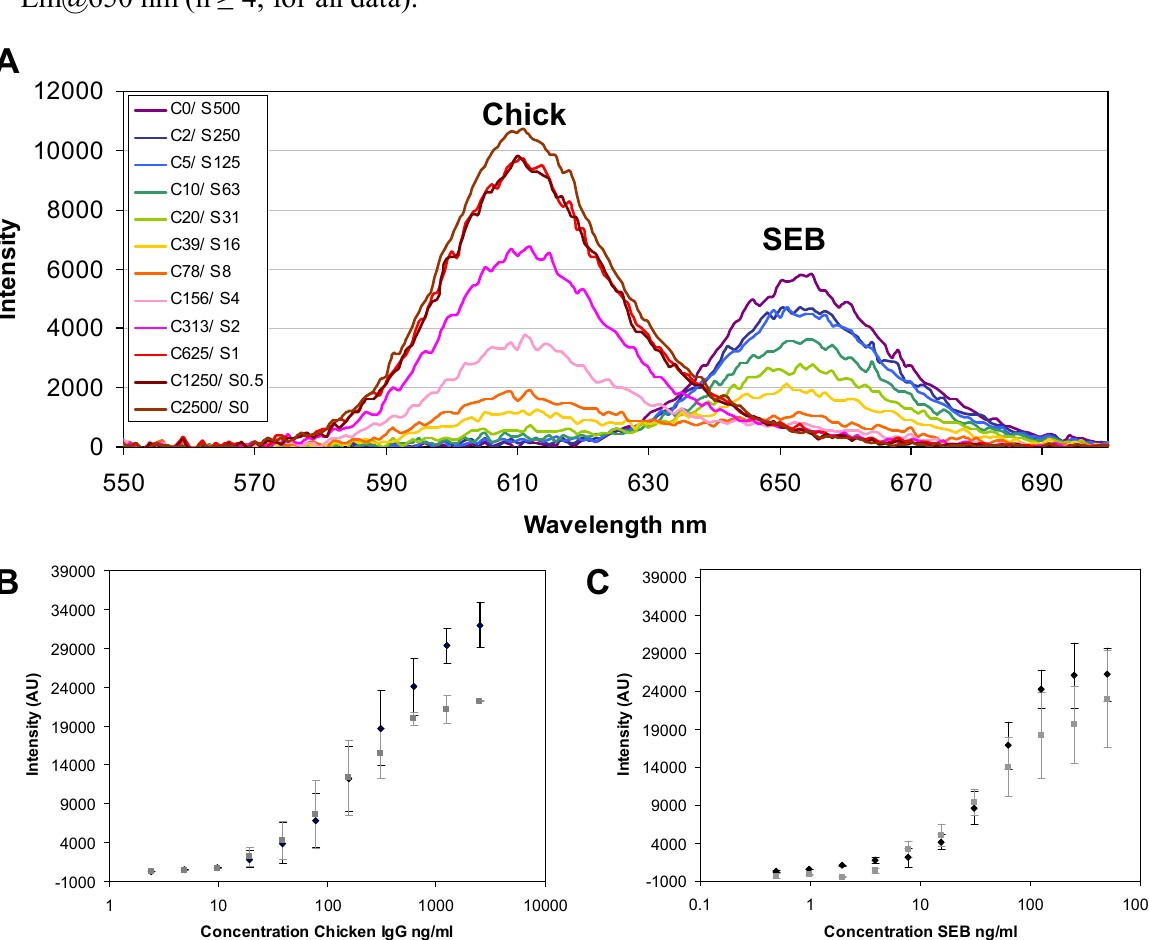
Figure 4. Duplex immunoassays. (A) Chicken and SEB immunoassay, microtiter well functionalized with capture antibodies for both chicken IgG (7.5 ug/mL) and SEB (2.5 ug/mL); the tracer comprised NC605-Rb-anti-Chicken IgG (1:400 dilution) and NC650-Rb-anti-SEB (1:100 dilution). The chicken (C) and SEB (S) concentrations exposed are indicated in ng/mL. (B) Dose response for the Chicken immunoassay in a single format versus duplex format. Single capture species combined with single NC-tracer ( ). Duplex capture species combined with duplex NC-tracers ( ). (C) Dose response for the SEB immunoassay in a single format versus duplex format. Single capture species combined with single NC-tracer ( ). Duplex capture species combined with duplex NC-tracers ( ). Intensity measurements were recorded at the emission maxima (Em) for each of